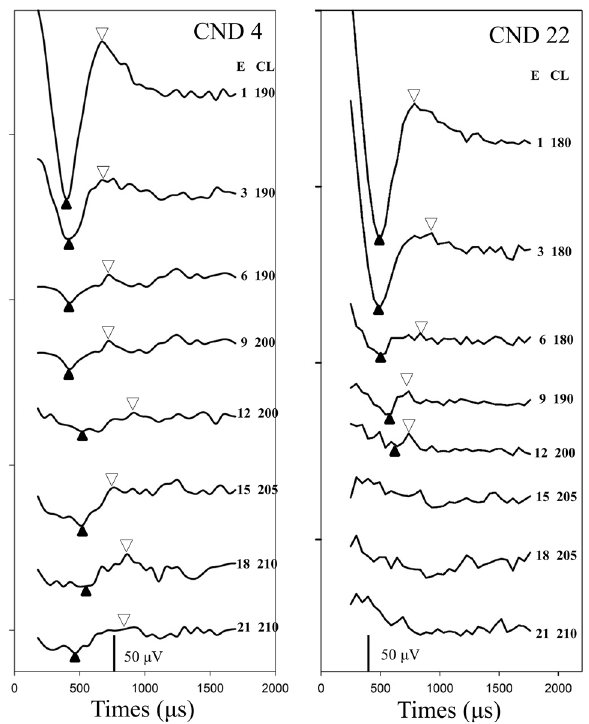
Figure 1. Traces recorded at some electrodes in CND4 and CND22. Subject number, the electrode location and stimulation level (current level, CL) used to evoke these traces are displayed on each panel. The pulse width used in CND4 and CND22 was 50 μs and 75 μs, respectively. The upward and downward triangle indicate the trough and peak of the electrically evoked compound action potential identified for the trace, respectively. E electrode location, CL current